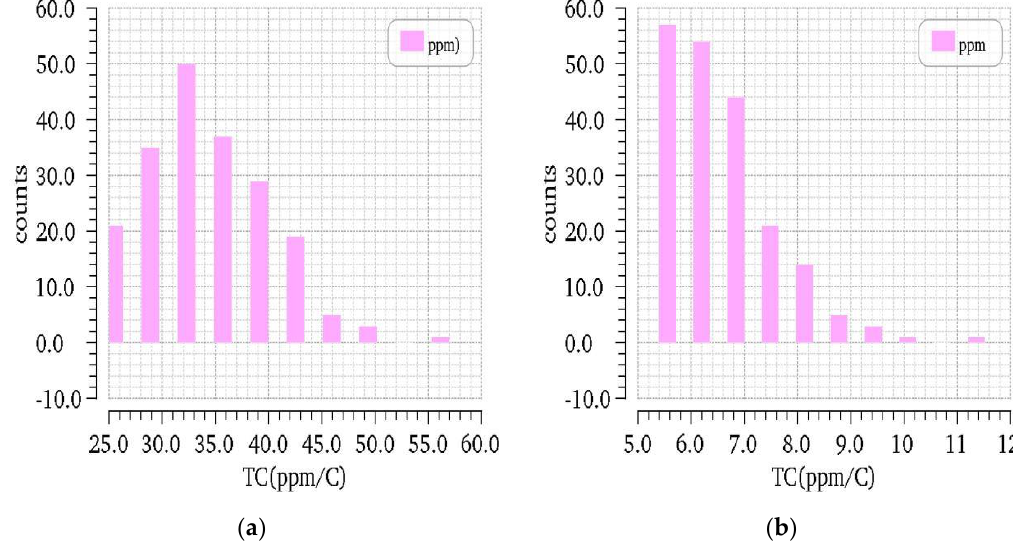
( b ) Figure 9. In reference 2 ( a ) 200 Monte Carlo simulation results for TC after first-order temperature compensation; ( b ) 200 Monte Carlo simulation results for TC after high-order temperature compensation. 3.4. High-Order Temperature Compensation Circuit The high-order temperature compensation circuit in Figure 3 is composed of a resis- tor, five Negative-Positive-Negative (NPN ) bipolar transistors, and three PMOSFETs; two PMOSFETs were removed from the circuit in Figure 4 in order to obtain the opposite com- pensation. Take circuit in Figure 3 as an example. According to Kirchhoff’s voltage law, V BE,Q7 can be expressed as: